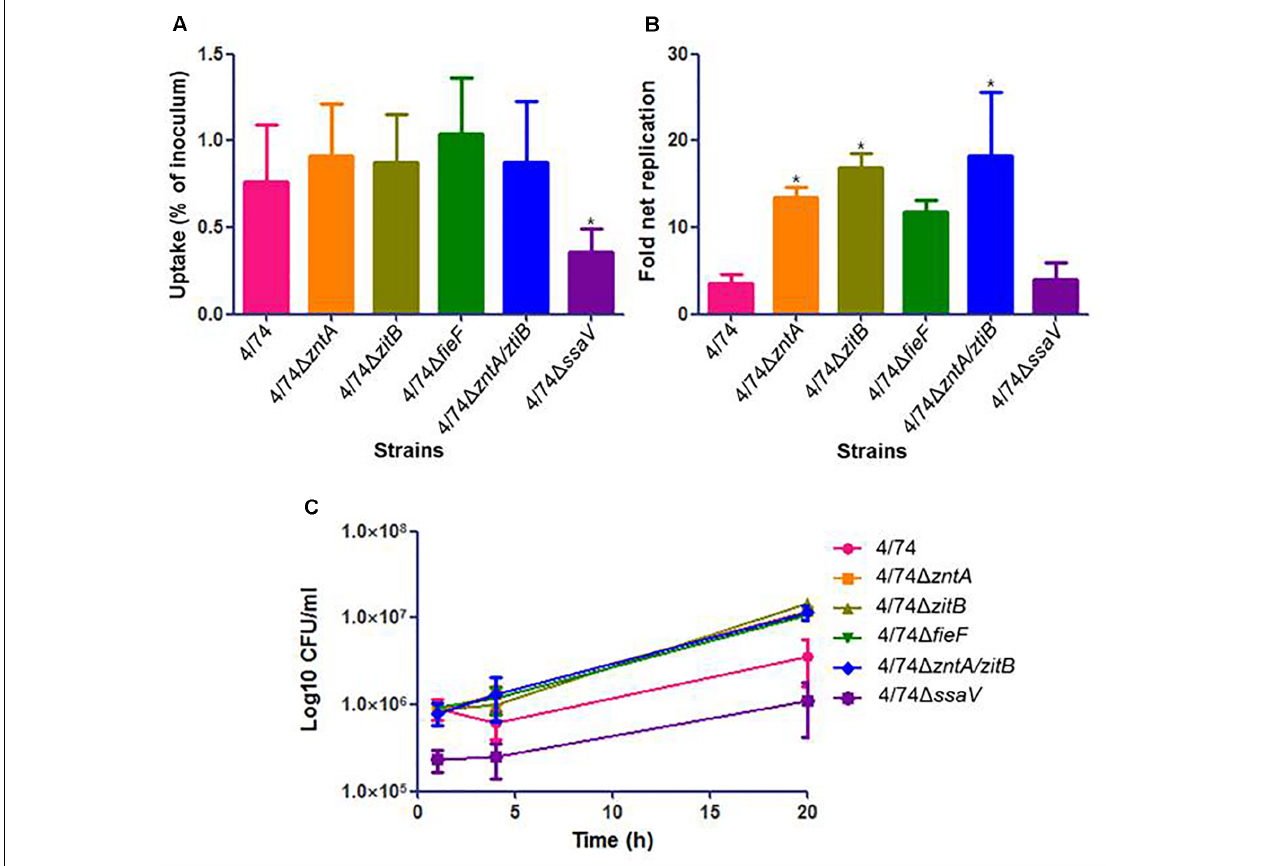
FIGURE 4 | Infection of Nramp1-positive macrophages (RAW264.7) with WT and zinc export mutants. (A) Uptake by macrophages (percentage of inoculated bacteria that are able to infect). No significant differences were observed in the uptake by macrophages between WT and mutants. (B) Fold net replication at t = 20 versus t = 1 h. Fold net replications of 4/74 (cid:49) zntA , 4/74 (cid:49) zitB , and 4/74 (cid:49) zntA/zitB mutants were significantly higher than that of the WT 4/74 ( P -value < 0.05). (C) Survival curves. At t = 20 h, all the mutants showed higher significant CFU counts than the WT ( P -value <